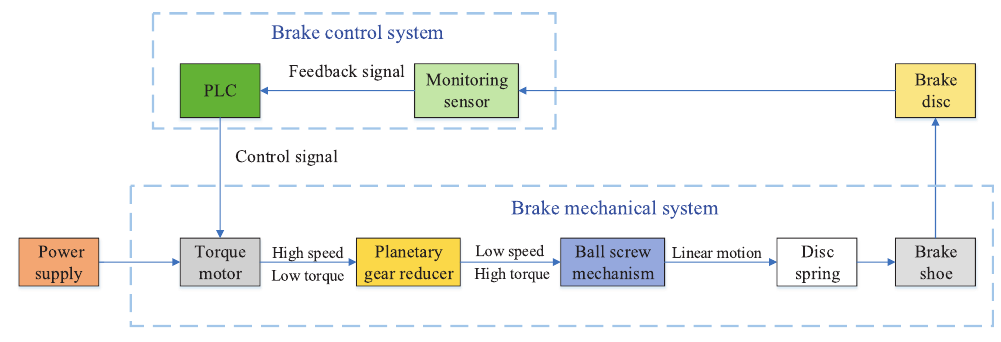
Fig. 4. Operating principle diagram of electro-mechanical braking